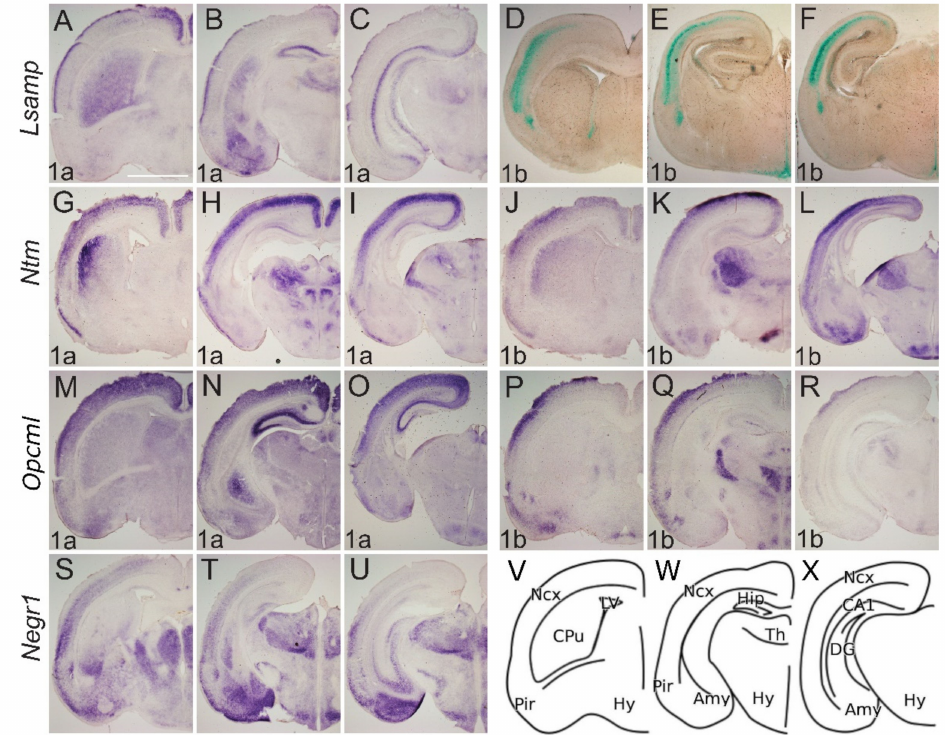
Figure 5. Expression from IgLON alternative promoters at P0 mouse CNS. ( A – C ; G – U ) In situ mRNA hybridization; ( D – F ) X-gal staining. ( A , D , G , J , M , P , S ) coronal sections through the level of olfactory tuberculum and septum. ( B , E , H , K , N , Q , T ) sections pass through the middle part of Amy and diencephalon; ( C , F , I , L , O , R , U ) through the caudal part of Amy and diencephalon. ( A – C ) Lsamp 1a is expressed laterally in the upper layer of the cortex and in the ammon horns of the hippocampus. Expression in CPu forms a medio-lateral gradient where the strongest expression is seen medially. Strong expression is seen in Amy. ( D – F ) Lsamp 1b in the cortex is seen below 1a expression domain and is missing from Amy. ( E , F ) expression of Lsamp 1b persists around the third ventricle. ( G – I ) Ntm 1a in cortical layers is broad and forms gradient being strongest at dorso-medial side. Strong expression is seen in Pir. Same pattern is seen with ( J , K ) Ntm 1b ; however, the expression is more restricted to upper layers of cortex. ( G , J ) in striatum Ntm 1a/1b is seen laterally immediately beneath the developing corpus callosum. Complementary expression of ( H , I ) Ntm 1a and ( K , L ) Ntm 1b is revealed in thalamic nuclei and Amy. ( M – O ) Opcml 1a is broadly expressed in the cortex, being strongest in the hippocampus. ( P – R ) Opcml 1b is restricted to the dorsolateral surface of the cortex and portion of thalamic nuclei. ( S – U ) Negr1 is broadly expressed in lateral surface of developing neo- and piriform cortex; ( U ) Negr1 expression in hippocampus is observable at caudal portion and is ( T , U ) strong in Amy and upper thalamic nuclei. ( V – X ) schemes of cutting planes. Abbreviations: Amy, amygdala; CA1, cornuammonis region 1; DG, dentate gyrus; CPu, caudal putamen; LV, lateral ventricle; Ncx, neocortex; Pir, piriform cortex; Th, thalamus; Hy, hypothalamus. Scale bar: 1